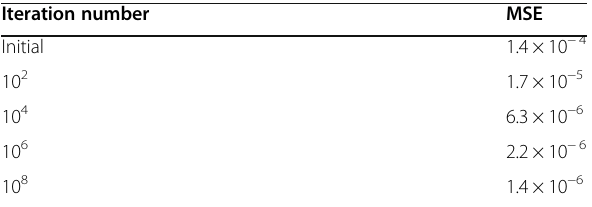
Table 4 MSEs for the 1D Gaussian curve study with noiseless